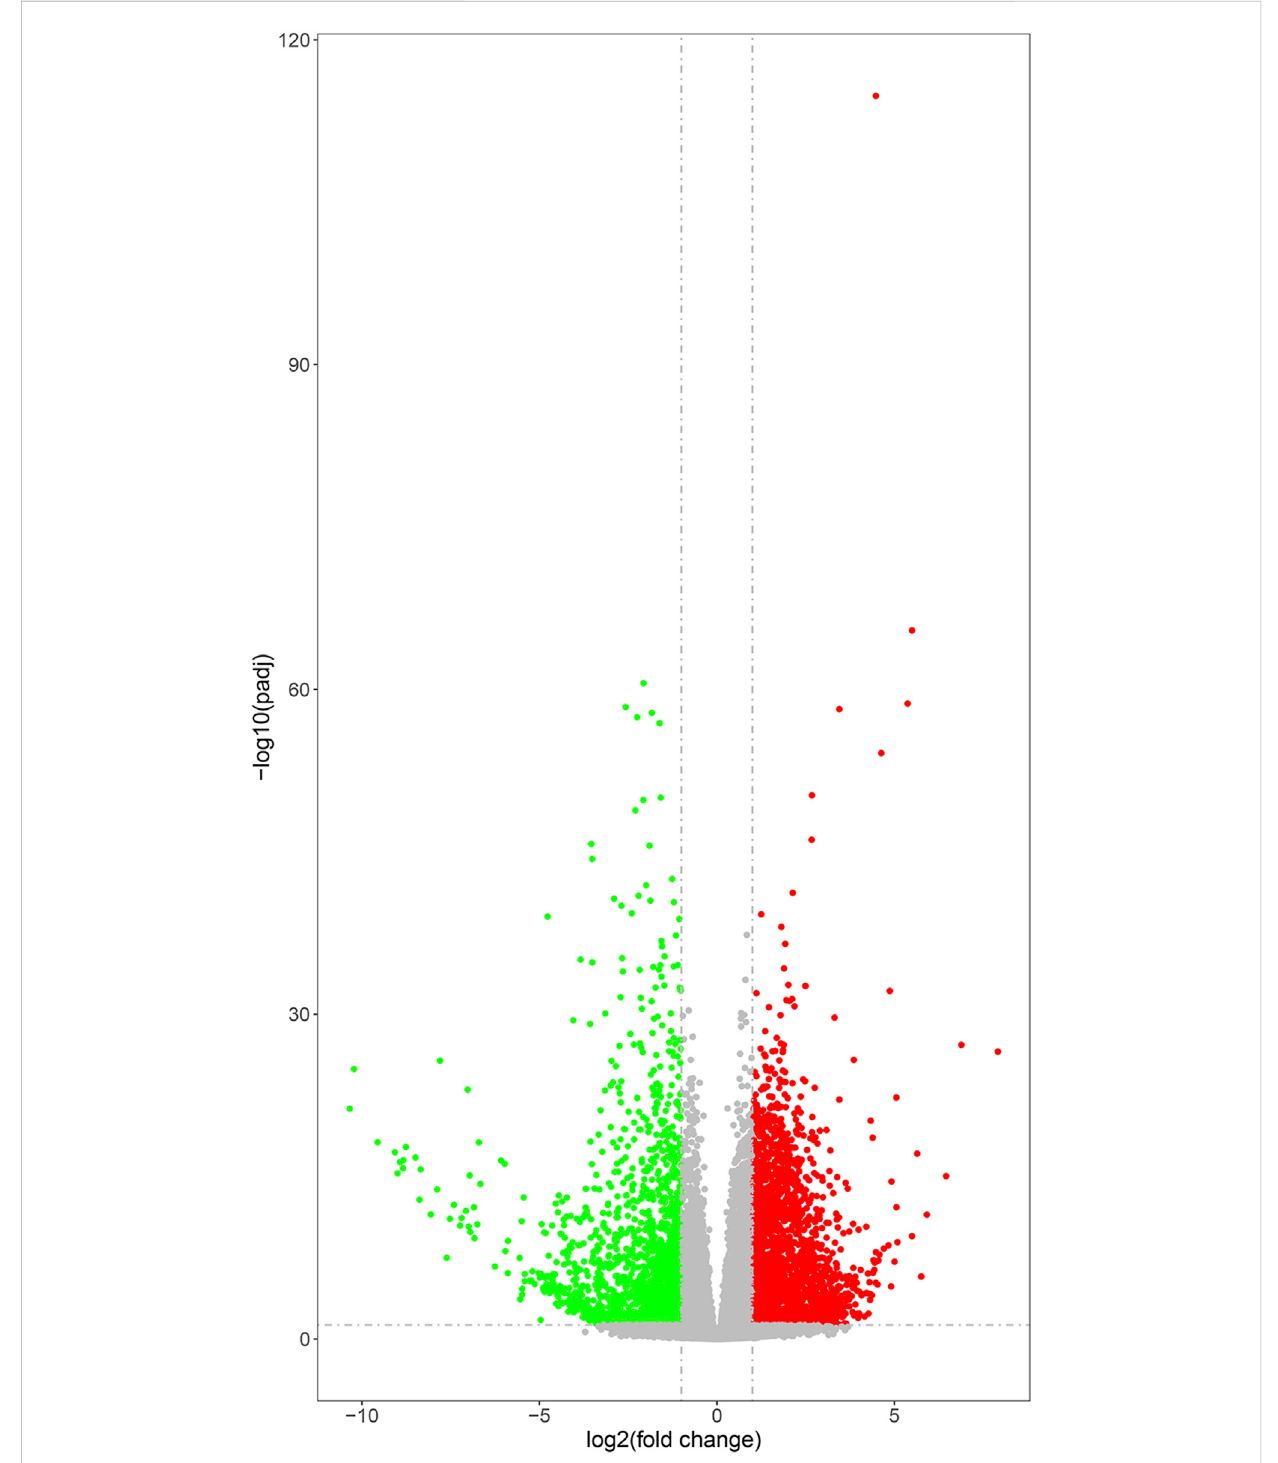
FIGURE 3 VolcanoplotsofDEGs.Thegraypointsrepresentgeneswithrelativelyunchangedexpression;thegreenpointsrepresentthedownregulatedgenes; and the red points represent upregulated genes. P -value was adjusted using q-value and q-value < 0.005, and log2 (fold change) > 1 was set as the threshold for signi fi cant differential